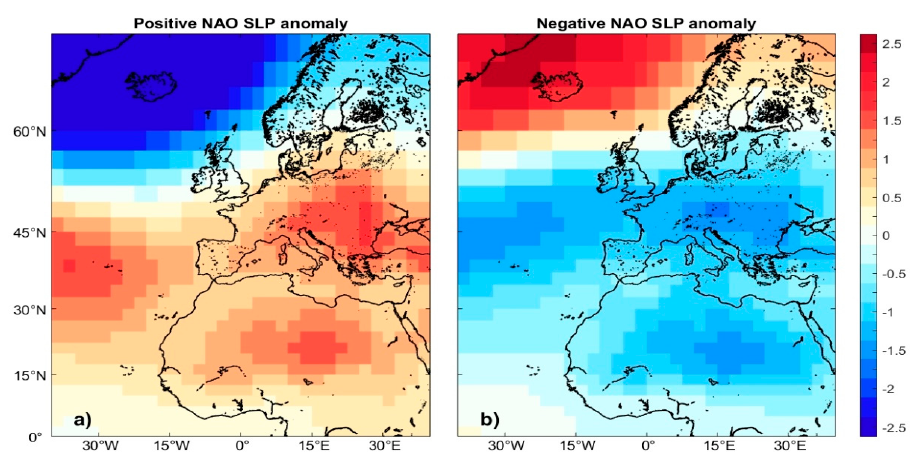
Figure 2. Composites of sea level pressure anomalies (mbar) in the period 1948–2008. Panel ( a ) reflects the positive phase (higher quartile) and panel ( b ) the negative phase (lower quartile) of the NAO.